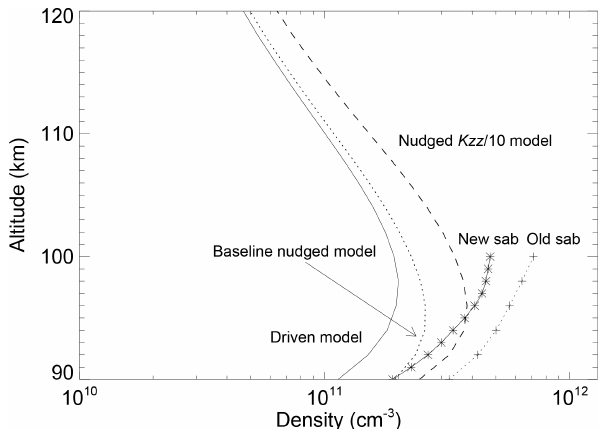
Figure 4. Ratio of nitric oxide from sunrise to late morning at 4 ◦ S. For the two models, this was done by taking the ratio of the nitric oxide averaged from 05:00–06:00LT (to approximate the local time of the SOFIE observations) to that at 11:00LT (roughly the local time of the SNOE observations). Also shown as the solid line is the ratio of the SOFIE data to the NOEM 2017 model shown in Fig. 2.